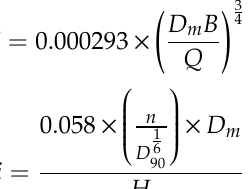
Figure 7. The upstream boundary conditions for the primary model: ( a ) The designed inlet flow hydrographs at the Ji-Lu Bridge (XS121.5). ( b ) The sediment supply rating curves of each size class, computed by the assistance model. Abbreviations of the su ffi x: Q s ,1 = size class 1, Q s ,2 = size class 2, Q s ,3 = size class 3, Q s ,4 = size class 4, Q s ,5 = size class 5, Q s ,6 = size class 6, Q s ,7 = size class 7, and Q s ,8 = size class